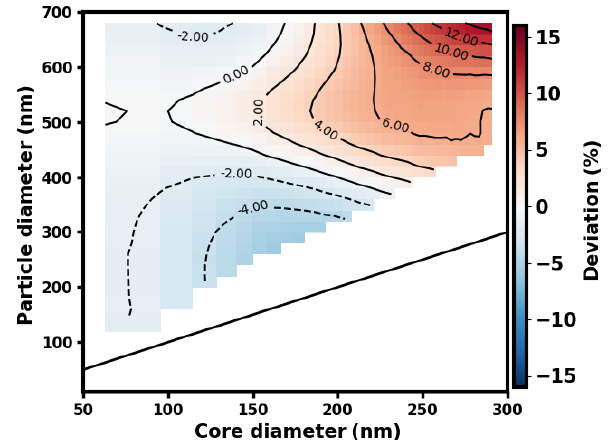
Figure 5. Relative deviations of the MAC values calculated by the idealized concentric core-shell model and letting BC particles be in the form of cluster-like aggregates. The solid line is the 1 : 1 line.